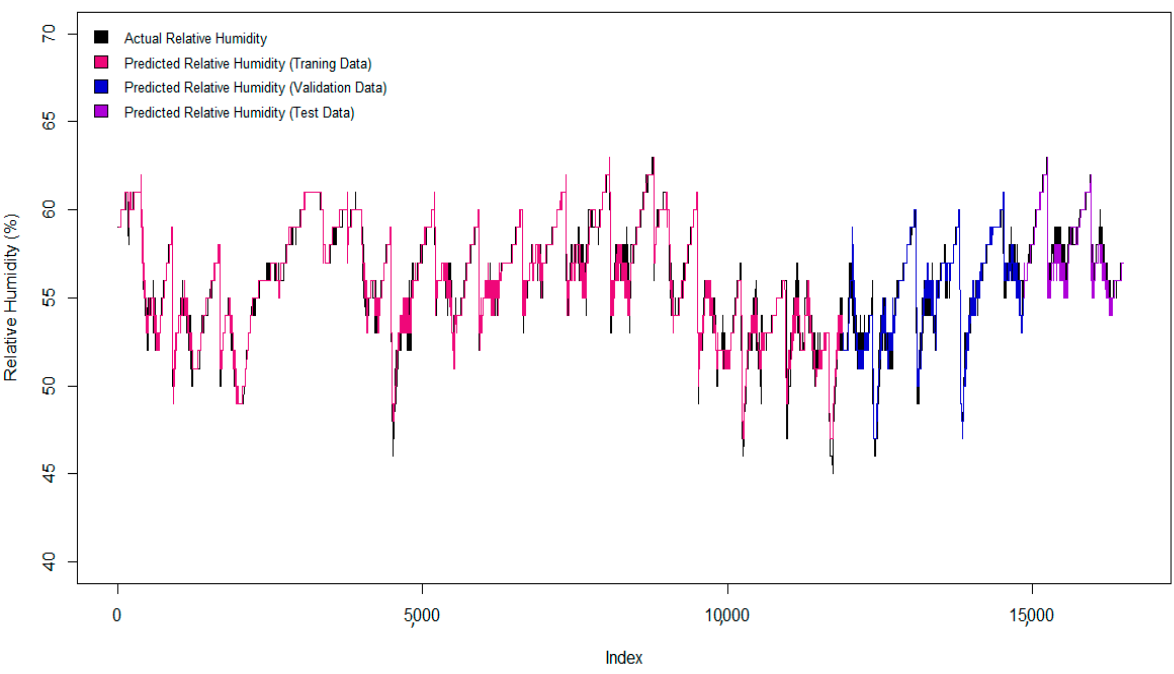
Figure 2. Actual relative humidity versus predicted relative humidity for the whole dataset using an LSTM model with including moving averages of some features.